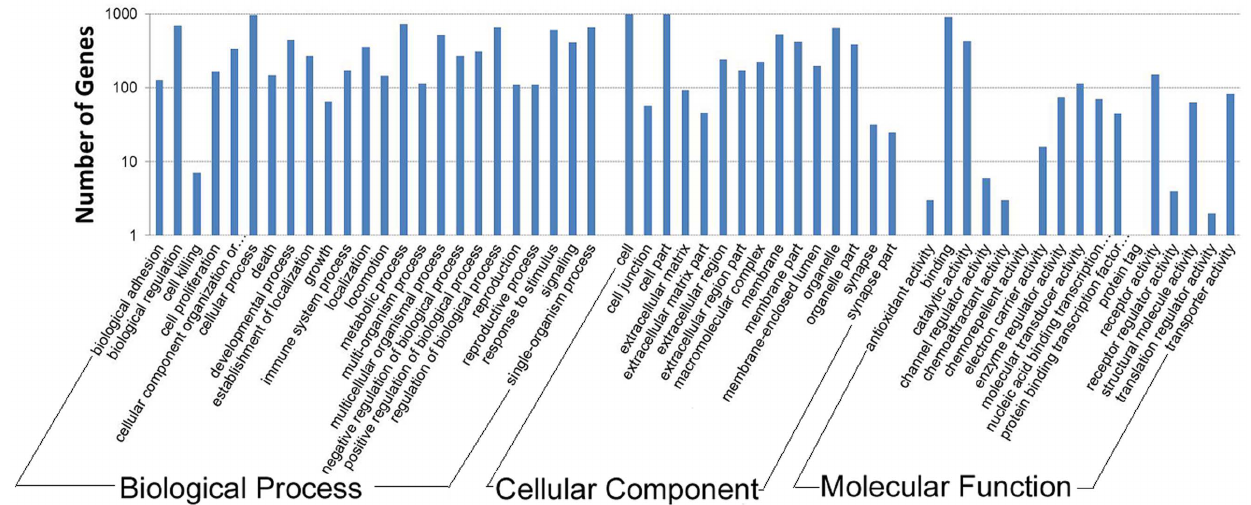
Figure 1. Gene ontology classification for the DEGs. The figure shows the GO enrichment of the differentially expressed genes in terms of molecular function, cellular components, and biological processes.